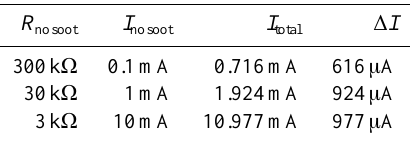
Figure 6. Magnification of Fig. 5 to determine the initiation time t i for coatings with different base resistances (without soot).